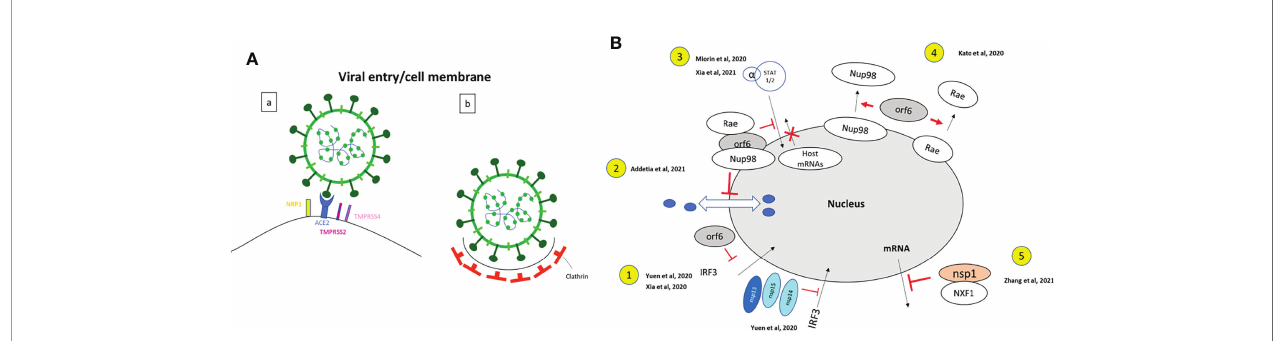
FIGURE 7 | Functional studies for the localization and functions of SARS-CoV-2 proteins. Enlargement of the dashed boxes of Figure 6 . (A) Viral entry: (a) Drawing based on data from (Cantuti-Castelvetri et al., 2020; Zang et al., 2020; Storti et al., 2021): Neuropilin-1 (NRP1) facilitates SARS-CoV-2 (Lentiviral particles pseudotyped with the SARS-CoV-2 S protein) cell entry and infectivity (Cantuti-Castelvetri et al., 2020). SARS-CoV-2 spike protein binds to ACE2 receptor, with colocalization of ACE2 and RBD of S protein (Storti et al., 2021); TMPRSS2 and TMPRSS4 facilitate SARS-CoV-2 spike fusogenic activity and promoted virus entry into host cells (Zang et al., 2020). (HEK293 cells were infected with VSV-SARS-CoV-2). (b) . Drawing based on data from (Storti et al., 2021). Clathrin has a role of mediator of late entry endocytosis of SARS-CoV-2 (infection of Vero E6 cells by SARS-CoV-2 isolated from patients). Strong colocalization of S protein with clathrin; confocal, Airyscan, dSTORM-TIRF and t -STED techniques are used to visualize single virions overlapping with clathrin. (B) Nucleus: Enlargement of the dashed box Figure 6 . Drawings based on literature indicated on the fi gure. 1. SARS-CoV-2 nsp13, nsp14, nsp15 and ORF6 (nsp13-FLAG, nsp14-FLAG, nsp15-FLAG and ORF6- FLAG) act as potent interferon antagonists and prevent IRF3 nuclear entry. A549 cells were transfected with ORF6-expressing plasmid (Xia et al., 2020; Yuen et al., 2020). 2. SARS-CoV-2 ORF6 interacts with Rae and Nup98 and disrupts bidirectional nuclear cytoplasmic transport. (GFP-ORF6 expressing plasmid transfected in 293T cells) (Addetia et al., 2021). 3. SARS-CoV-2 ORF6 interacts Nup98 to block STAT nuclear import and interfere with interferon signaling. (HEK293T transfected with ORF6-HA expressing plasmid) (Miorin et al., 2020; Xia et al., 2020). 4. SARS-CoV-2 ORF6 dislocates Nup98 and Rae from the nuclear pore complex and relocalizes them to the cytoplasm (Hek293T cells transfected with ORF6-GFP expressing plasmid) (Kato et al., 2021). 5. SARS-CoV-2 Nsp1 disrupts the mRNA export machinery, by interacting with the host mRNA export receptor heterodimer NFX1-NXT1. (Hek293T cells transfected with GFP-Nsp1 expressing plasmid) (Zhang et al.,